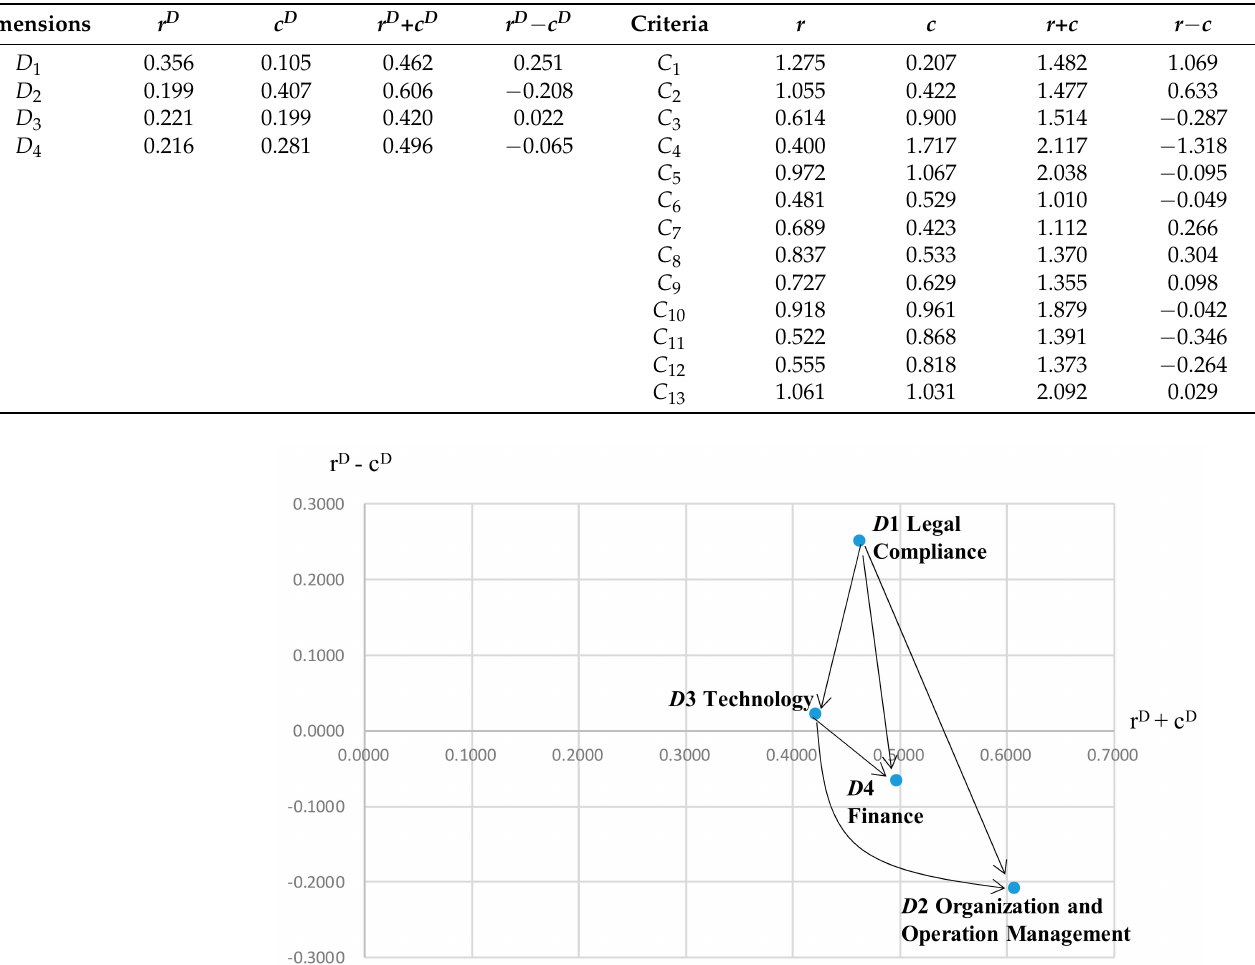
Figure 2. Dimensional cause–effect relationship